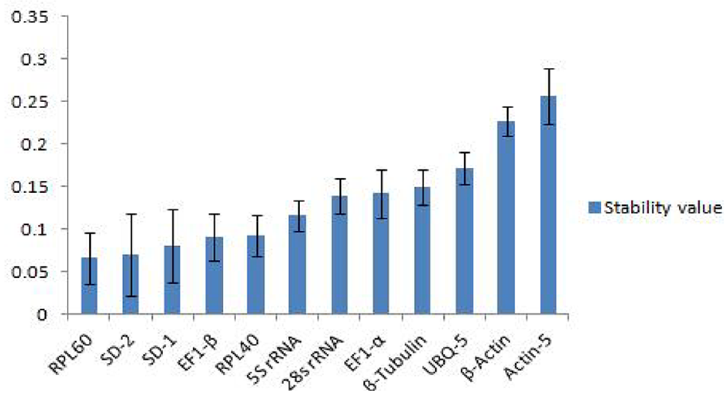
Fig 4. Expression stability of 12 candidate reference genes analyzed by Norm Finder